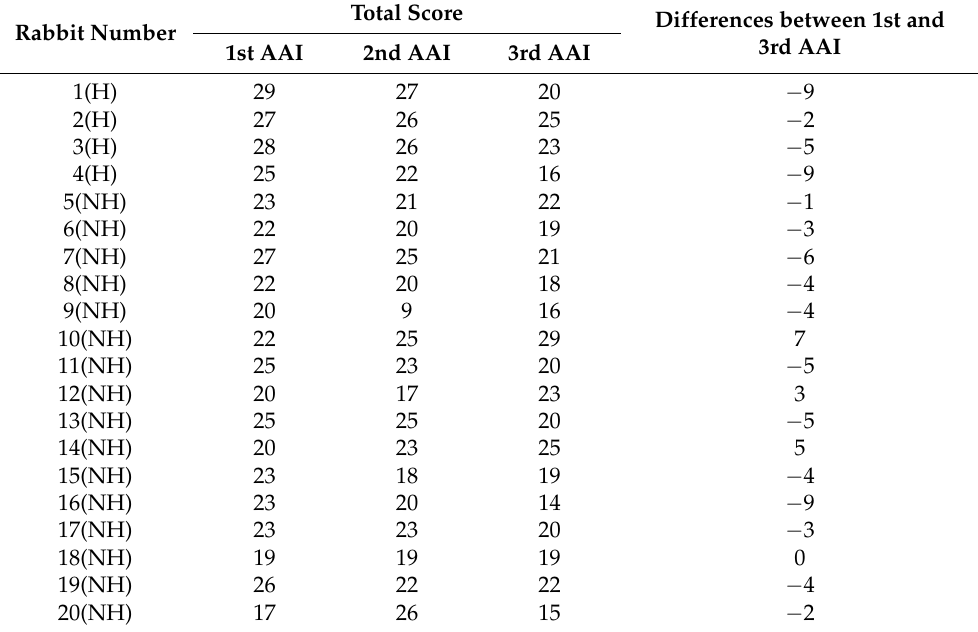
Table 3. Results of the Children Approach Test in